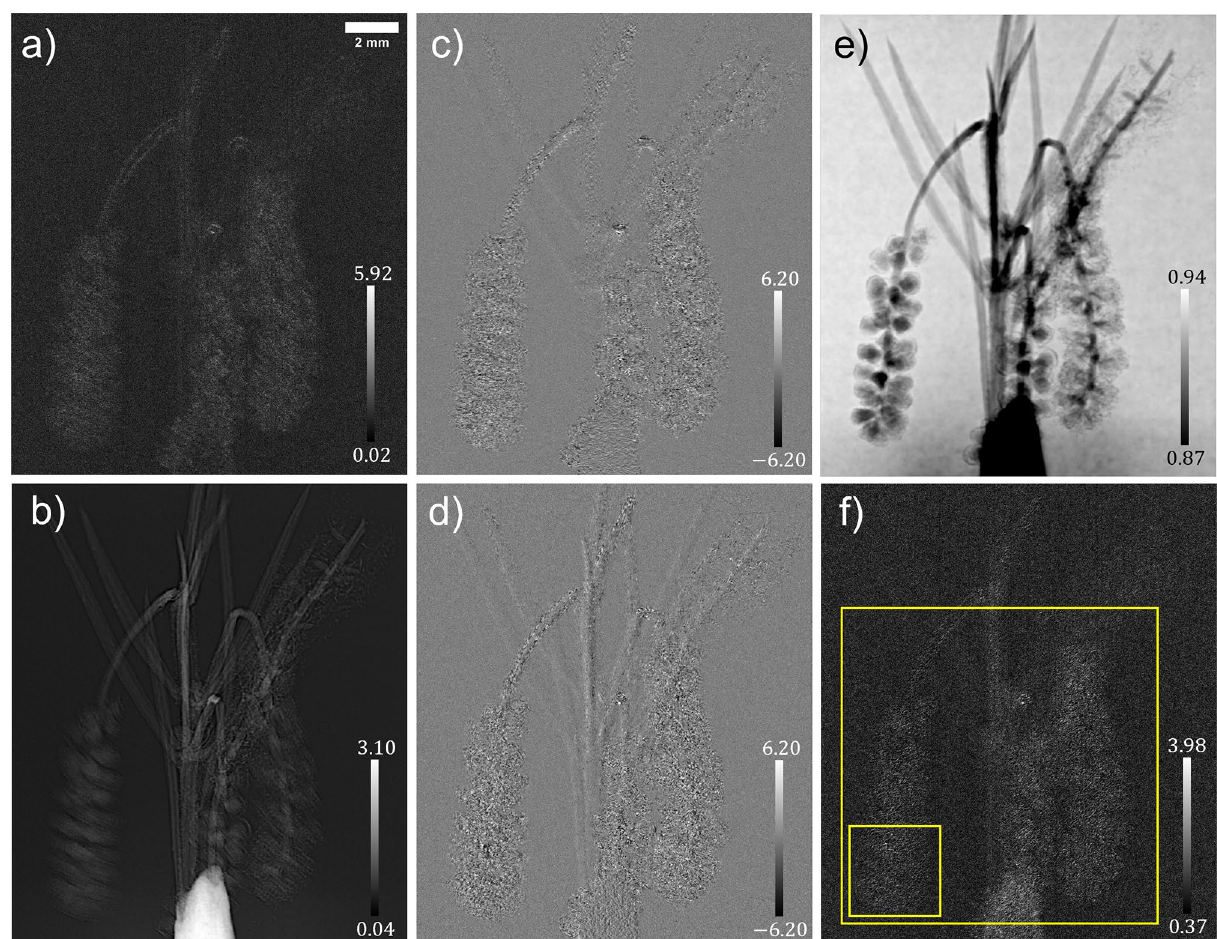
Figure 3. Solutions of the system of linear equations, equation (6), and the wattle flower’s reconstructed multimodal signals; ( a ) is the effective diffusion coefficient, D eff, Phase ( r ; �) , ( b ) is 1 ∇ 2 φ ob ( r ) − D eff, Phase ( r ; �) , ( c , d ) are the two spatial derivatives of the effective diffusion coefficient, ⊥ k Recon ( r ; �) and D x ( r ; �) , respectively, ( e ) is the reconstructed attenuation term, I ob ( r ) , and ( f ) is D y (cid:30) (cid:31) eff, Phase eff, Phase the wattle flower’s optimally filtered true effective diffusion coefficient, D True eff, Atten ( r ; �) . The greyscale bars in subfigures ( a , f ) are × 10 − 5 µ m, ( b ) is × 10 − 7 µ m − 1 , and ( c , d ) are × 10 − 6